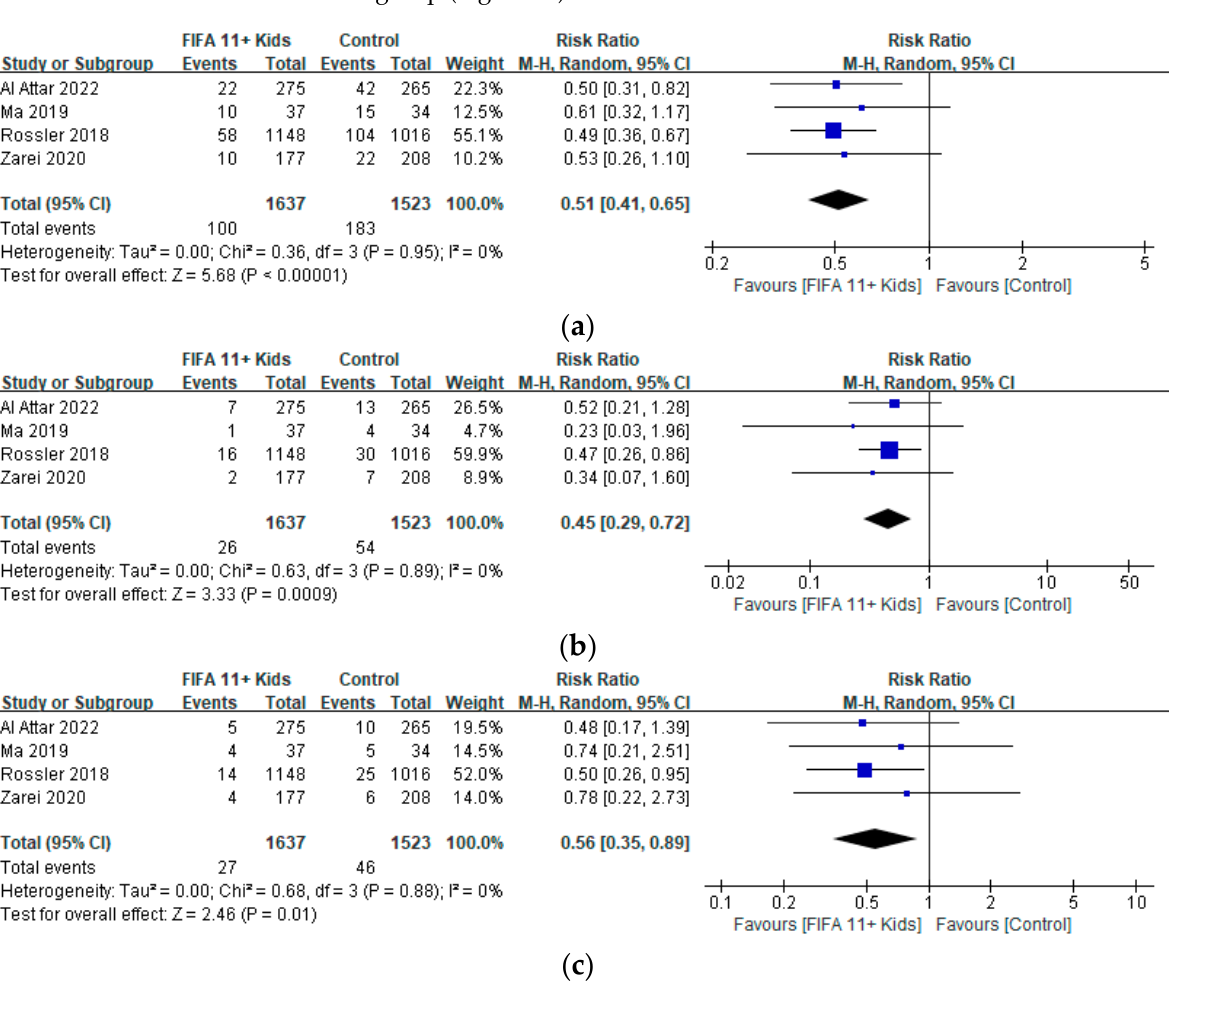
Figure 4. ( a ) Secondary analyses of injury rates in relation to conducting the “FIFA 11+ Kids” Program compared with control intervention on the number of lower extremity injuries [16,17,29,30]. ( b ) Secondary analyses of injury rates in relation to conducting the “FIFA 11+ Kids” Program compared with control intervention on the number of knee injuries [16,17,29,30]. ( c ) Secondary analyses of injury rates in relation to conducting the “FIFA11+ Kids” Program compared with control intervention on the number of ankle injuries